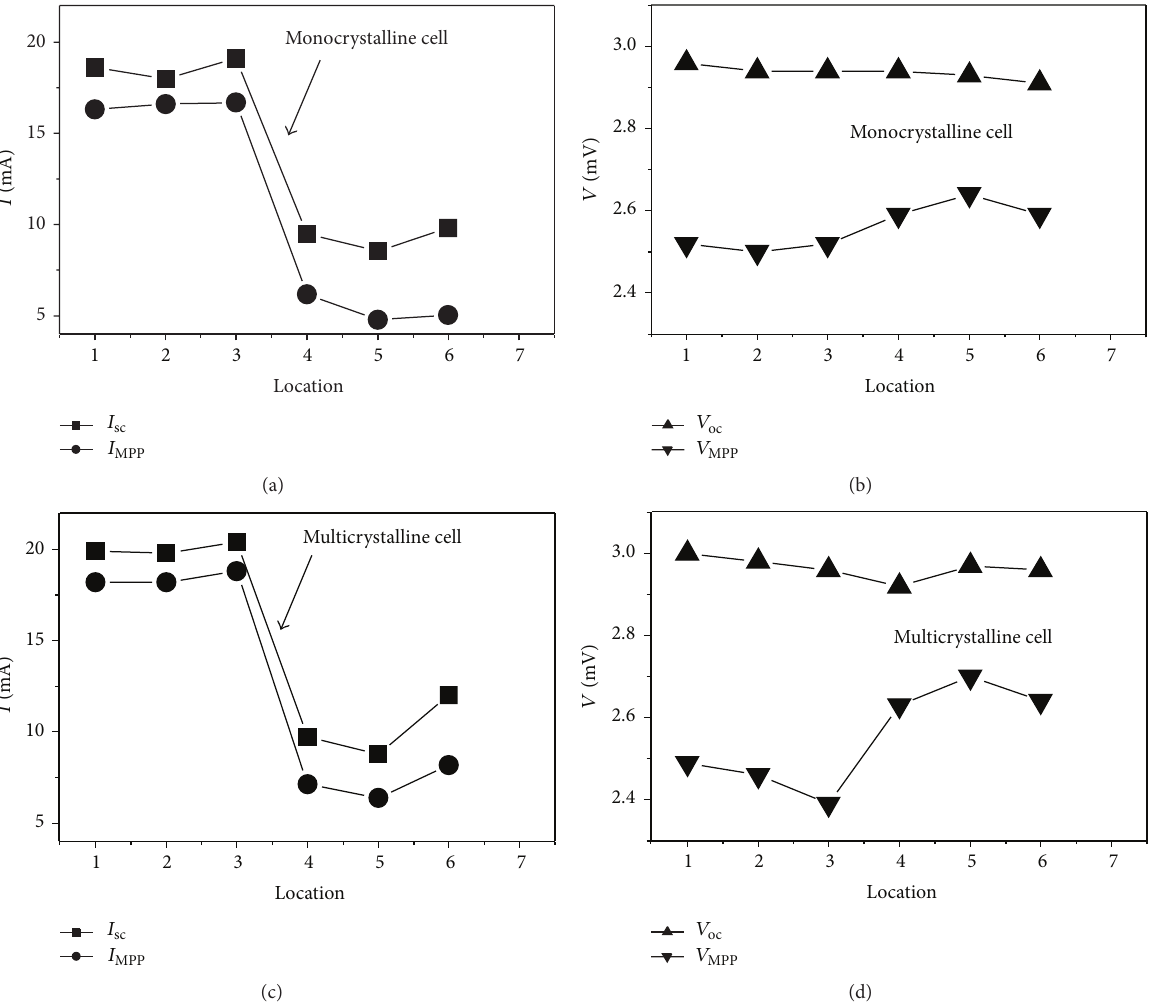
Figure 3: 𝐼 , 𝐼 MPP , 𝑉 , and 𝑉 MPP of monocrystalline ((a) and (b)) and multicrystalline ((c) and (d)) silicon solar cells against six rectangle sc oc shelter